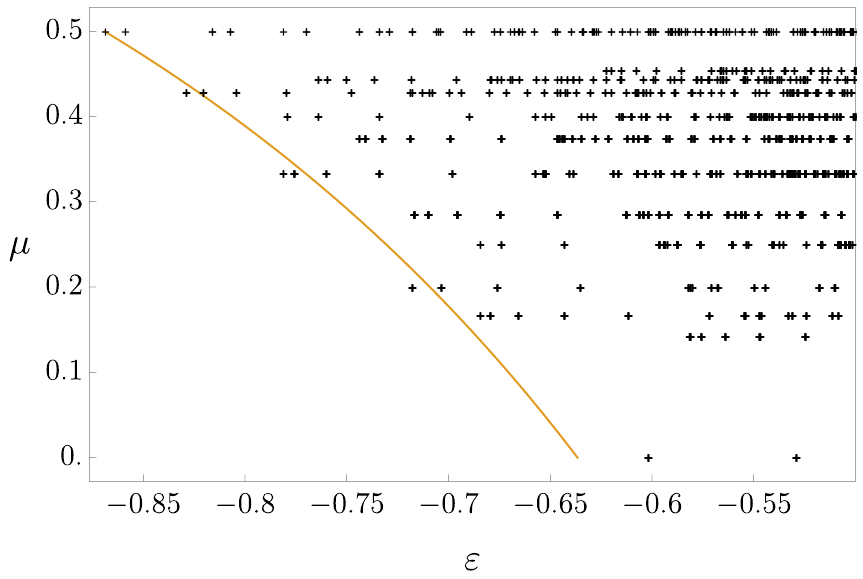
of the eigenstates (black sym- N 0 , for L = 18. The orange curve is F